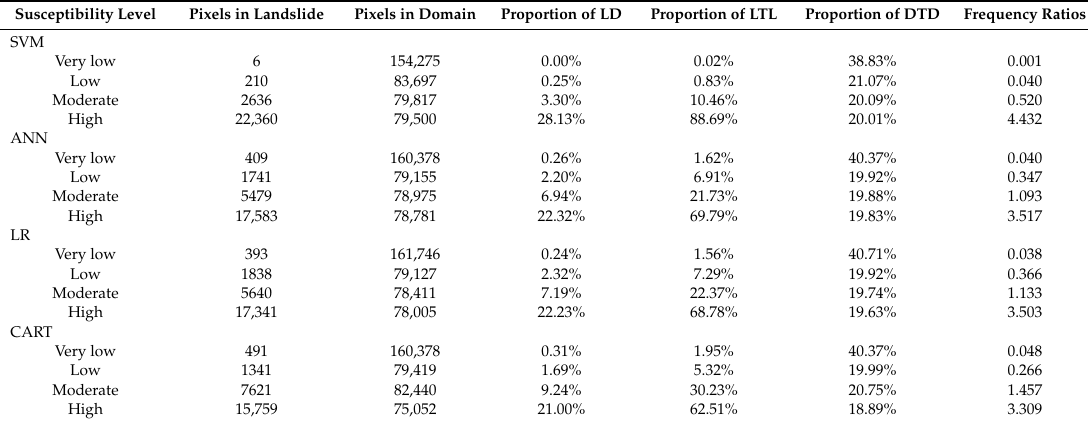
Table 7. Accuracy statistics of the SVM, ANN, LR, and CRAT